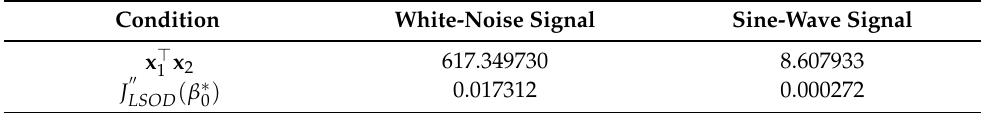
x 2 (39) and the value of Minimum condition J (cid:48)(cid:48) 1